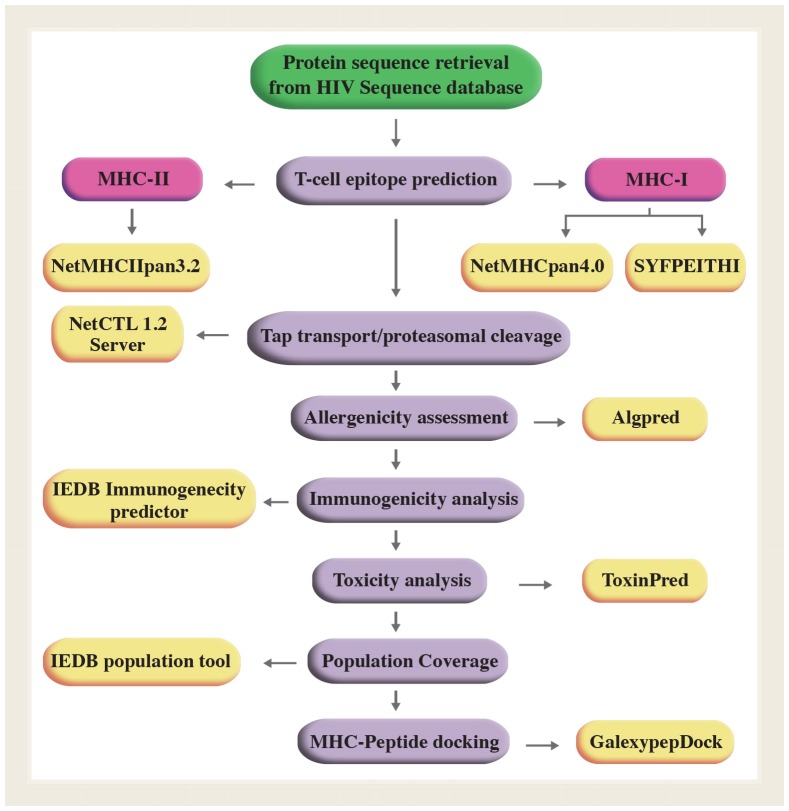
The overall process of polyepitope peptides design.